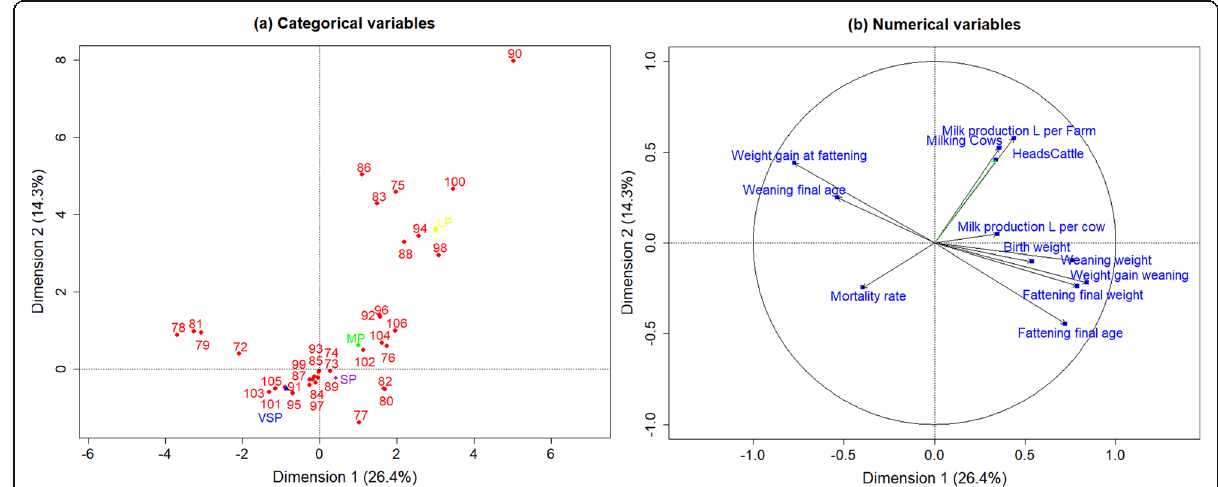
Fig. 5 Spatial projection of a categorical variables and b numerical variables for the component production and reproduction information. Coding of categorical and numerical variables is shown in Table S3 of the Supplementary material